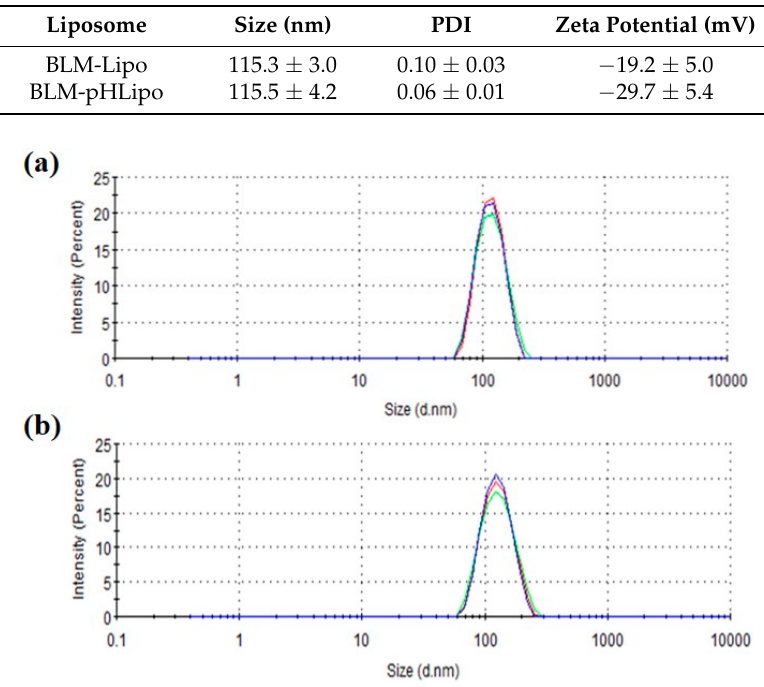
Table 1. Characterization of liposomes. BLM-Lipo: BLM-loaded PEG-modified liposomes, BLM-